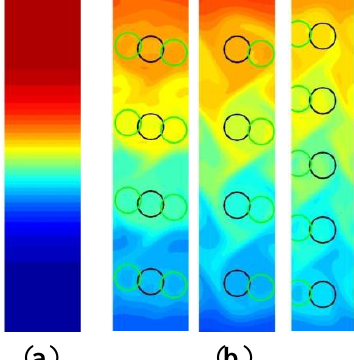
Figure 4. Comparison of mixing efficiency between pure diffusion ( a ) and magnetic mixer without channel flow after 100 bead revolutions ( b ). The concentration is averaged over channel height. The back circles denote the position of static discs, whereas the green circles indicate the instant position of rotating beads. In (b) , left, 2 beads rotation per disk with 2a spacing; middle, 1 bead per disk with 2a spacing; right, 1 bead per disk with 1.5a spacing.